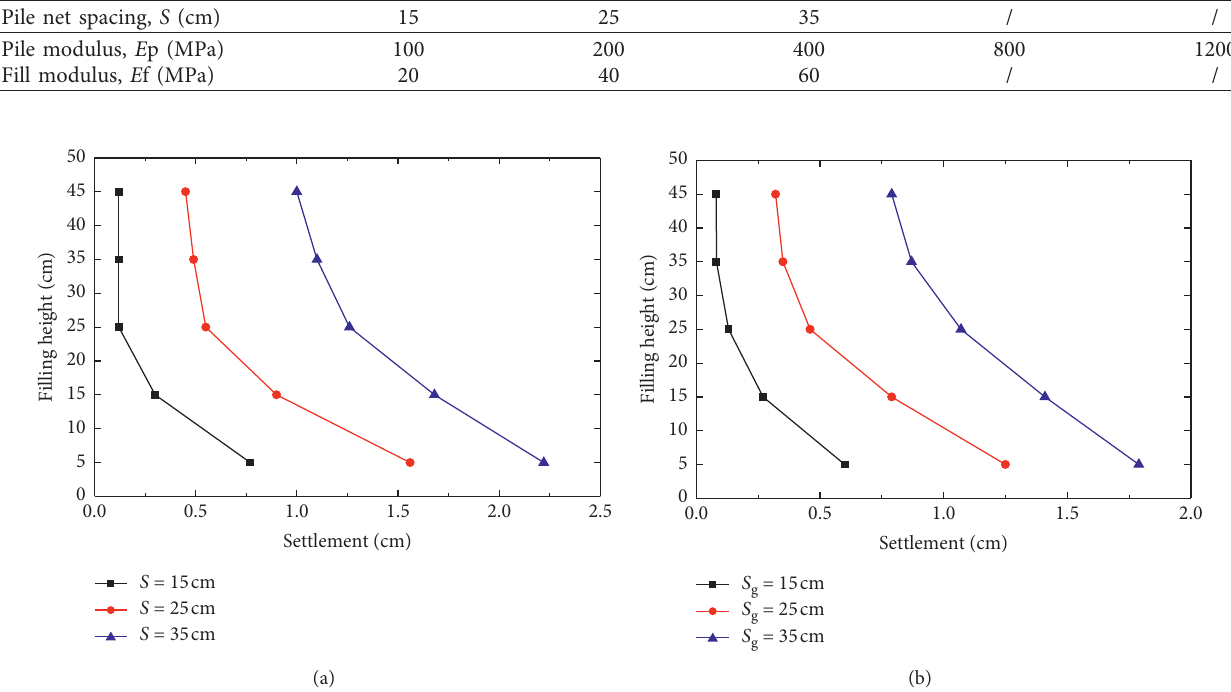
Figure 11: Variation of the settlement with filling height under different pile net spacing conditions. (a) Unreinforced condition. (b) One- layer geogrid-reinforced condition.